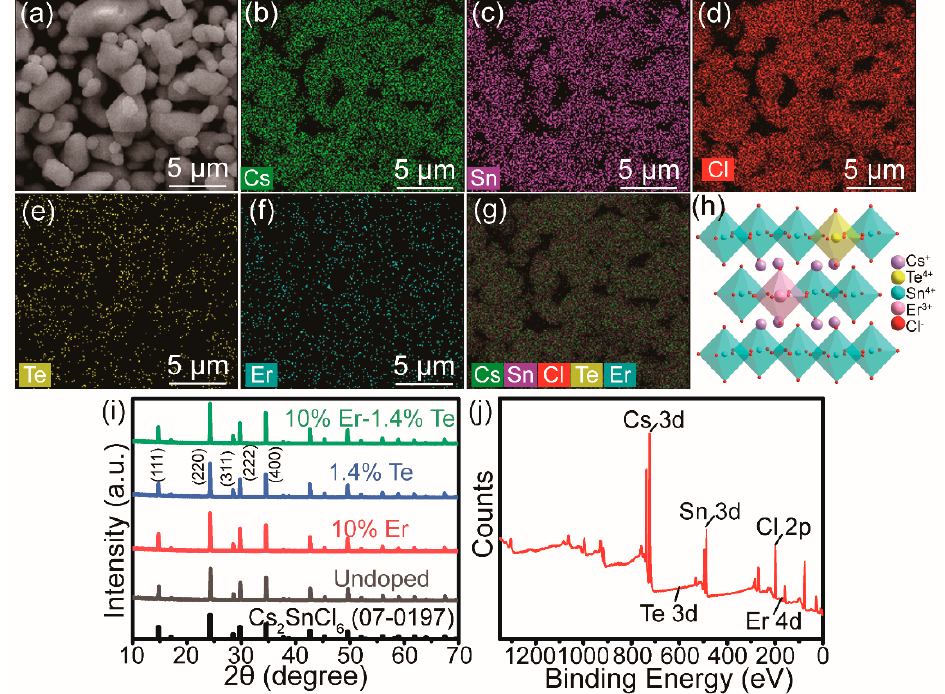
Figure 1. ( a ) SEM image, ( b – g ) EDS elemental mappings (Cs, Sn, Cl, Te, Er, and merge), and ( h ) crystal structure of cubic Te 4+ /Er 3+ -co-doped Cs 2 SnCl 6 . ( i ) XRD pa tt ern of undoped, Er 3+ -singly doped, Te 4+ -singly doped, and Te 4+ /Er 3+ -co-doped Cs 2 SnCl 6 microcrystals. The 2 θ peaks located at 14.8°, 24.2°, 28.5°, 29.7°, and 34.5° correspond to the (111), (220), (311), (222), and (400) di ff raction planes, respectively. ( j ) XPS survey spectrum of Te 4+ /Er 3+ -co-doped Cs 2 SnCl 6